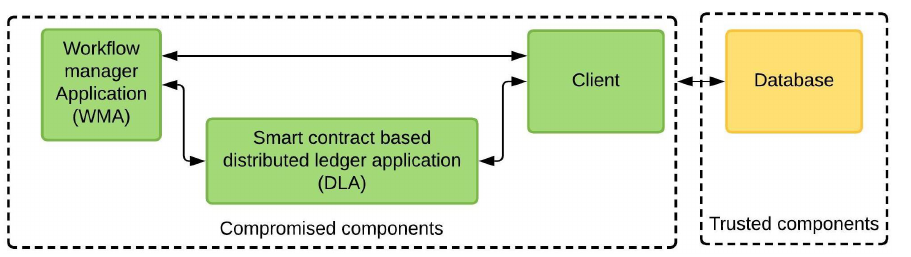
Figure 2. Workflow architecture of the proposed